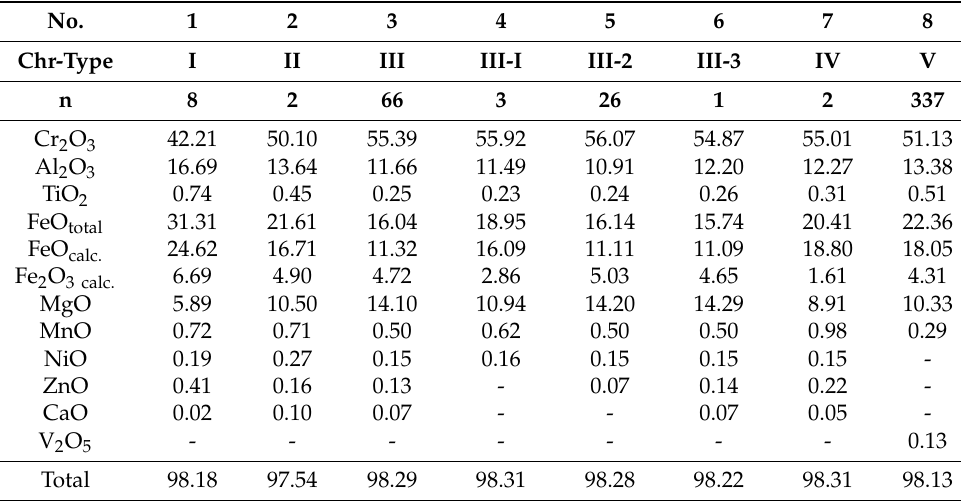
Table 2. The average chemical composition of the Cr-spinel morphological types from the Sopcheozero deposit (wt.%)